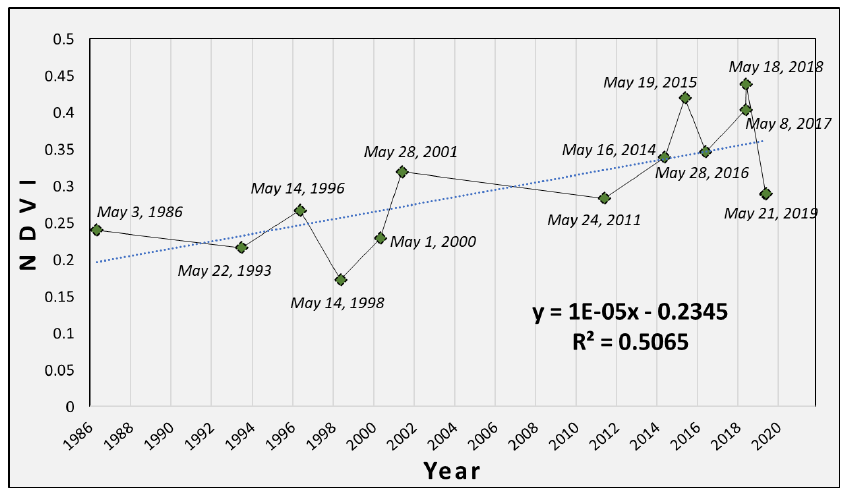
Figure 5. Yearly normalized difference vegetation index (NDVI) means across the 80 UGSs.